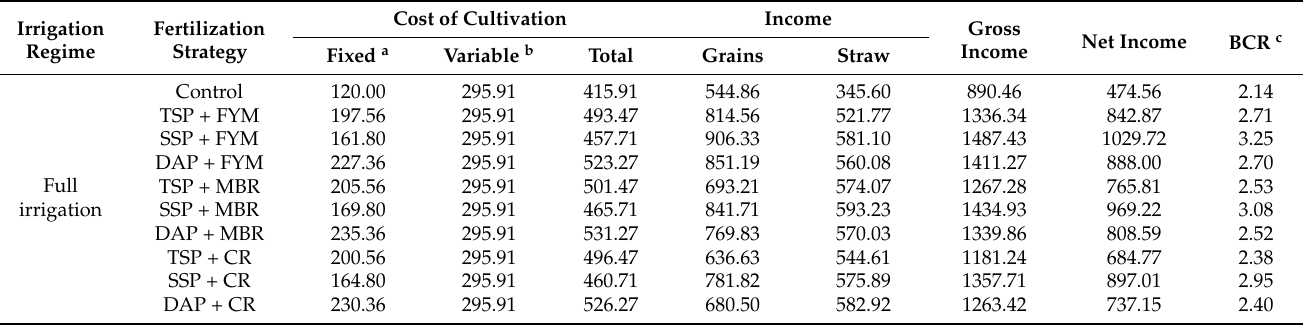
Table 7. Economic study of wheat grown in Mardan (Pakistan) during winter 2019 – 2020 after sup- plementing inorganic phosphorus with organic supplements under restricted and assured irrigation regimes.